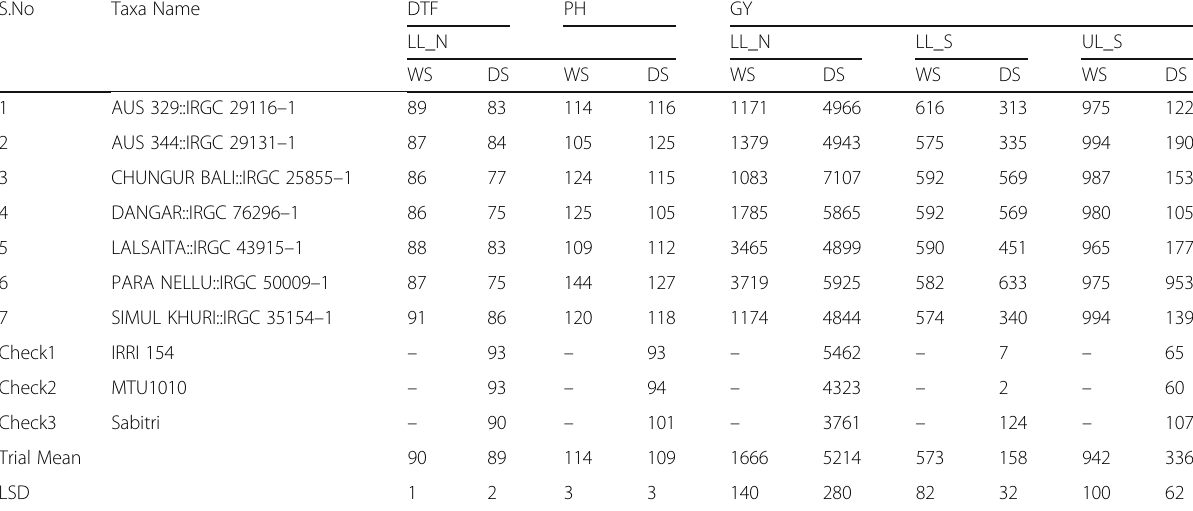
Table 4 Selected promising accessions on basis of grain yield advantage across seasons and environments